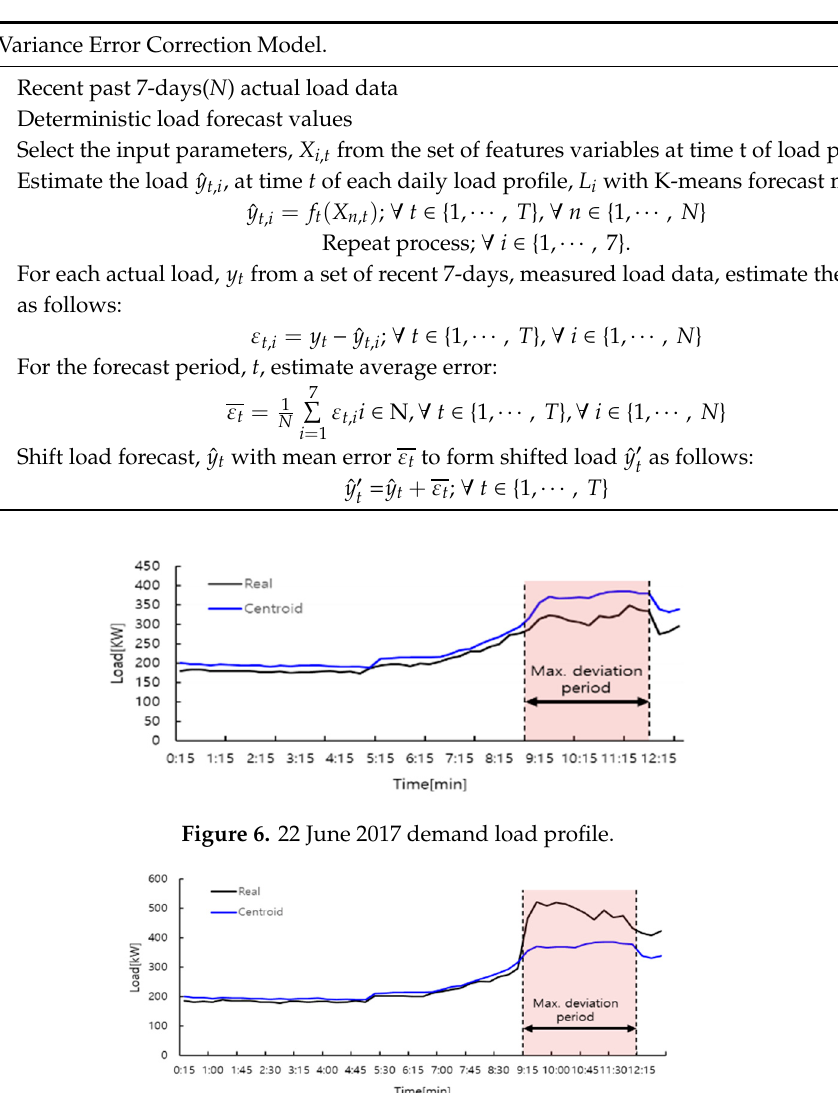
9 of 19 Algorithm 1 : Algorithm for Stochastic Demand Load Forecast. Input: